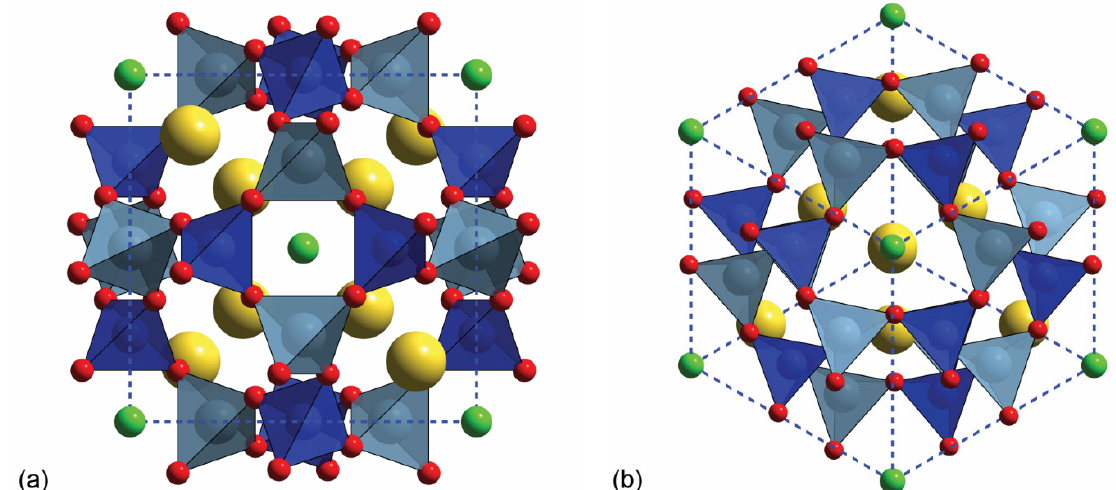
Figure 1. Sodalite Na 8 (Al 6 Si 6 O 24 )Cl 2 polyhedral model seen along ( a ) the [100] and ( b ) the [111] directions. The dashed blue lines show the mineral lattice. Colour code for atoms: blue—Si; cyan—Al; red—O; yellow—Na and green—Cl.